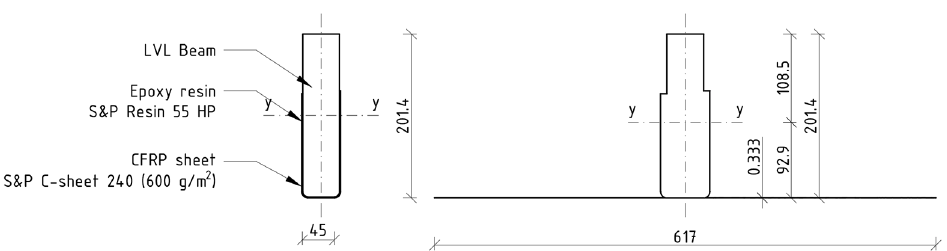
Figure 7. Transformed cross section of beam B3